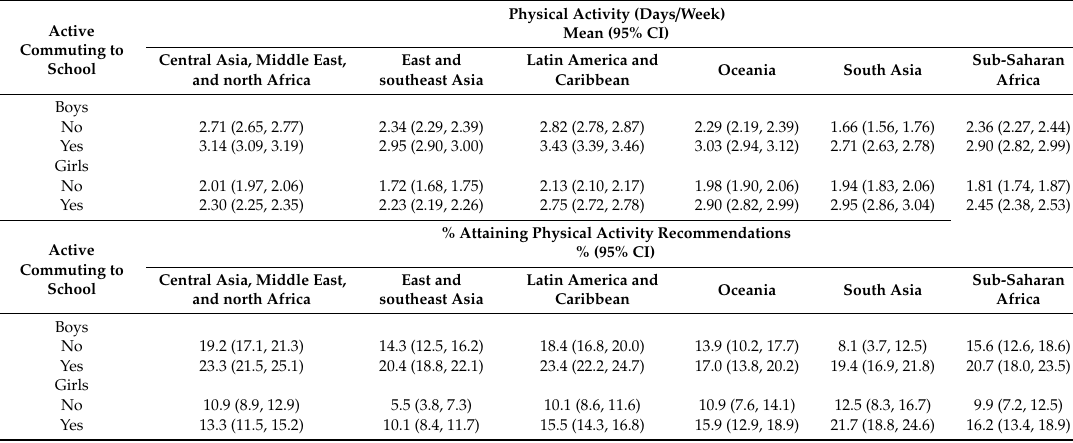
Table 3. Mean frequency of physical activity (days / week) and the prevalence of attaining the physical activity recommendations according to active commuting by regions.